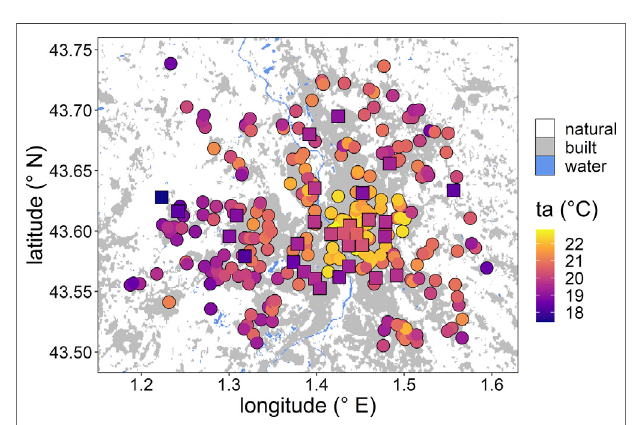
FIGURE 11 | Mean air temperature ( ta ) in Toulouse during July 2020 03:00 UTCasmeasuredbyCWS(circles)andPRWS(squares).CWSdataaredisplayed at QC level o3 after application of CrowdQC+ in default settings (cf. Table 2 ). UnderlyinglandcoverderivedfromtheLCZmap(natural:LCZA-F,built:LCZ 1-10, water: LCZ